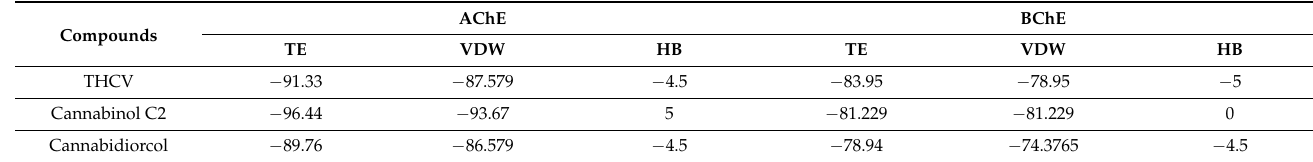
Table 4. Docking energies of compounds with AChE and BChE receptors by